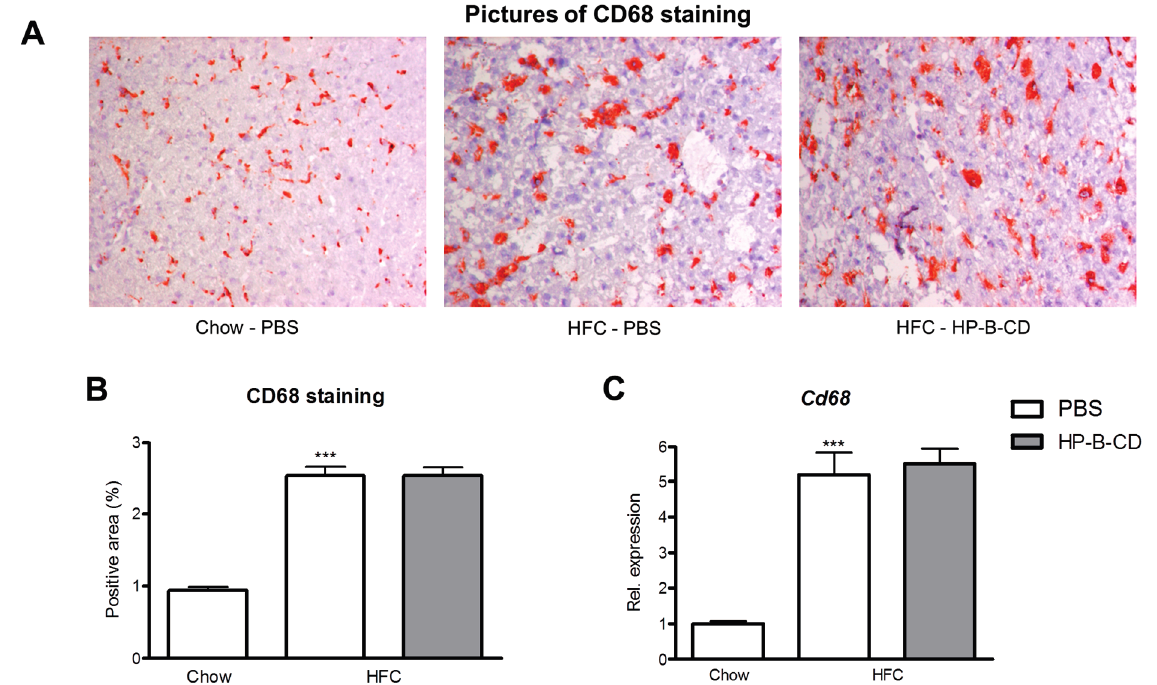
Figure 2. Hepatic CD68 expression. ( A ) Representative histological pictures of the CD68 staining (original magnification, 200×) performed on liver sections of chow, PBS-injected and HP-B-CD-injected HFC-fed mice; ( B ) Quantification of the percentage CD68-positive area; ( C ) Hepatic gene expression analysis of Cd68 . Gene expression data are shown relative to chow. Data are expressed as mean ± SEM ( n = 10 for the chow-fed mice; n = 12 for the mice fed an HFC diet without treatment; n = 12 for the HFC-fed mice receiving HP-B-CD treatment). * Significantly different from chow. *** indicates p <